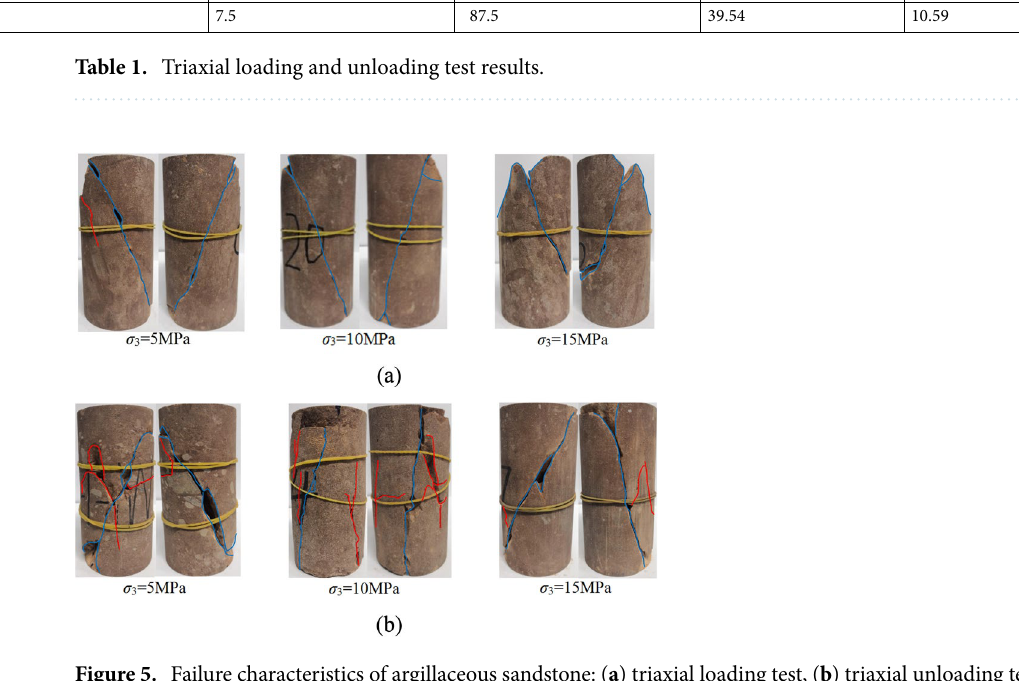
Figure 5. Failure characteristics of argillaceous sandstone: ( a ) triaxial loading test, ( b ) triaxial unloading